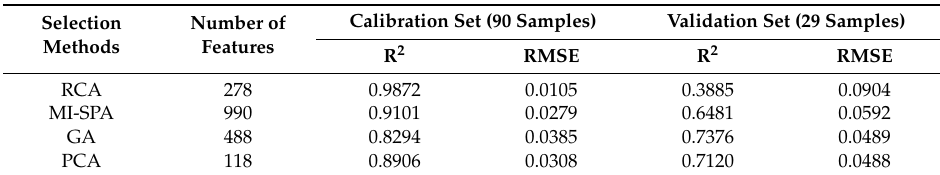
Table 2. PLSR pomelo water detection results combined with SG + MSC and different wavelength selection methods.